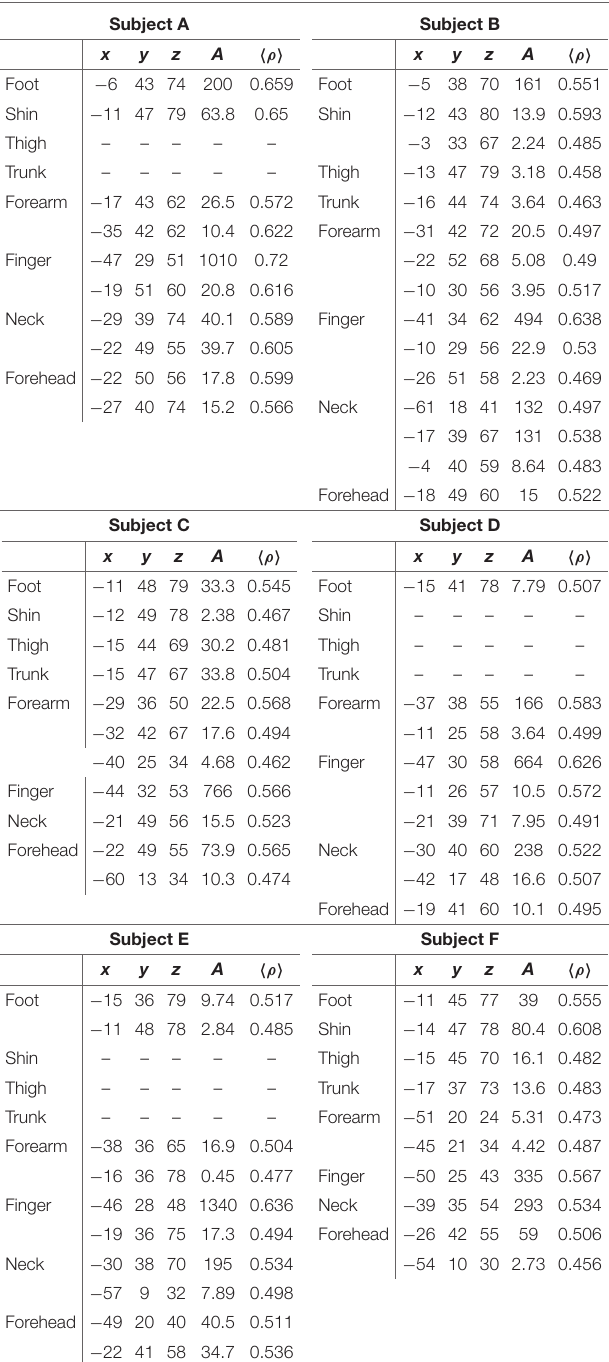
TABLE 1 | Centers of mass of activated clusters.